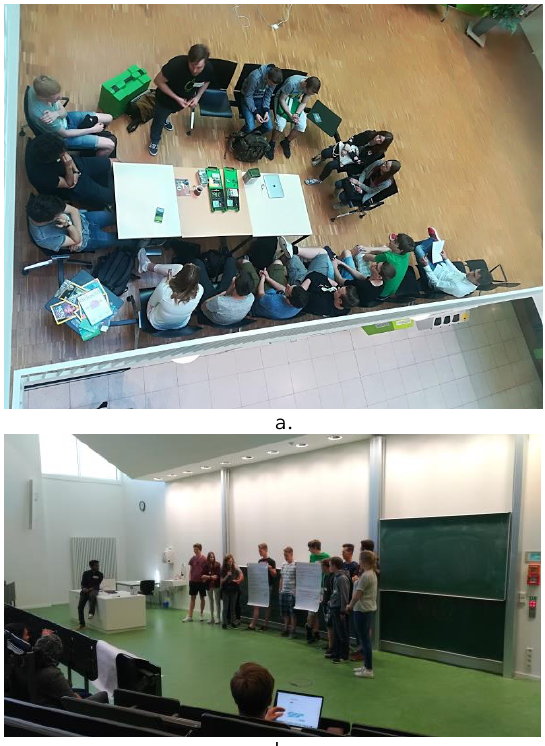
Figure 1: a. presenting ongoing research about senseBox in IFGI, b. school students presenting their project